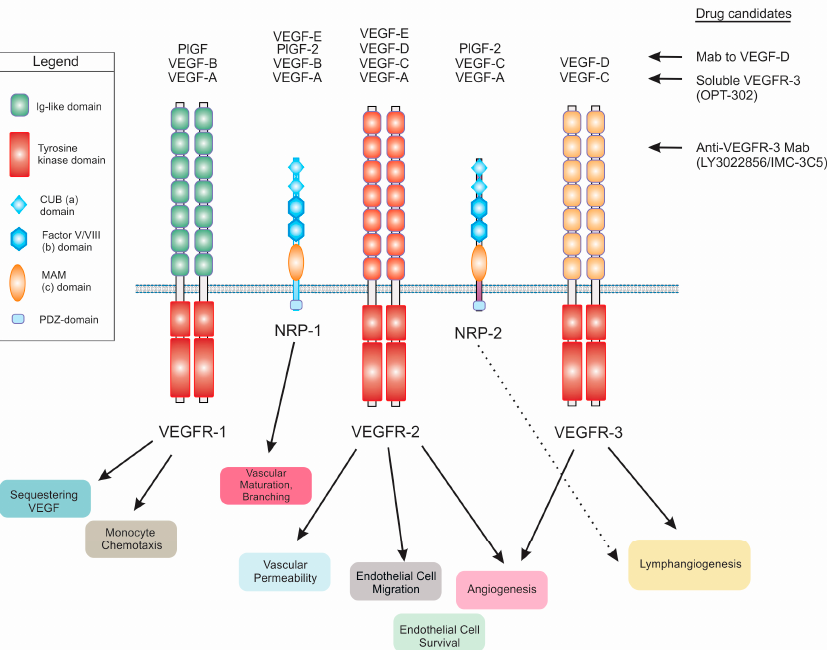
Figure 1. Schematic diagram illustrating the interaction of vascular endothelial growth factor-D (VEGF-D), and other VEGFs, with VEGF receptors (VEGFRs) and Neuropilin (NRP) co-receptors. Biological processes influenced by binding of ligands to the receptors are shown below, and selected drug candidates that can restrict VEGF-D signaling are listed to the right with “Mab” denoting monoclonal antibody. Note that soluble VEGFR-3 and anti-VEGFR-3 Mab also modulate VEGF-C signaling. “PlGF” denotes placenta growth factor, Ig denotes immunoglobulin, CUB denotes complement-binding, PDZ denotes a domain found in post synaptic density protein (PSD95)/Drosophila disc large tumor suppressor (Dlg1)/zonula occludens-1 protein (zo-1) and MAM denotes domain with homology to meprin A5 and mu-phosphate.